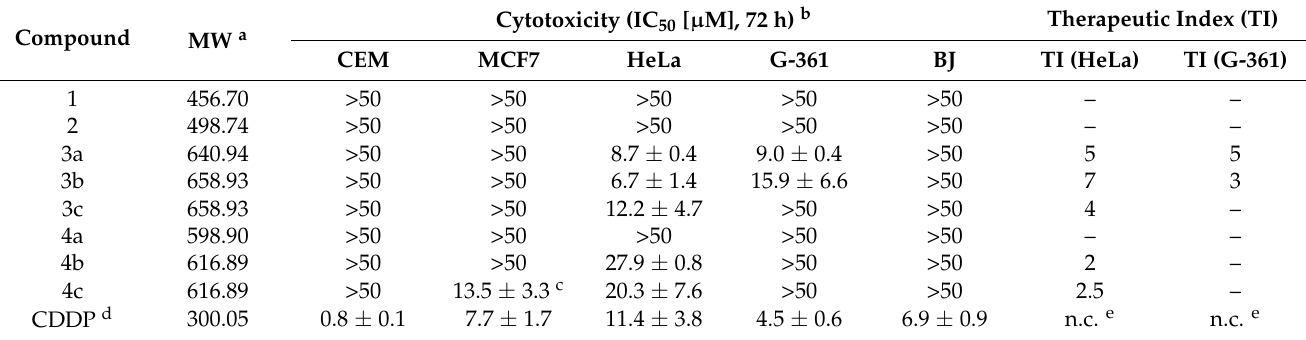
Table 1. Cytotoxicity screening tests (IC 50 [ µ M], 72